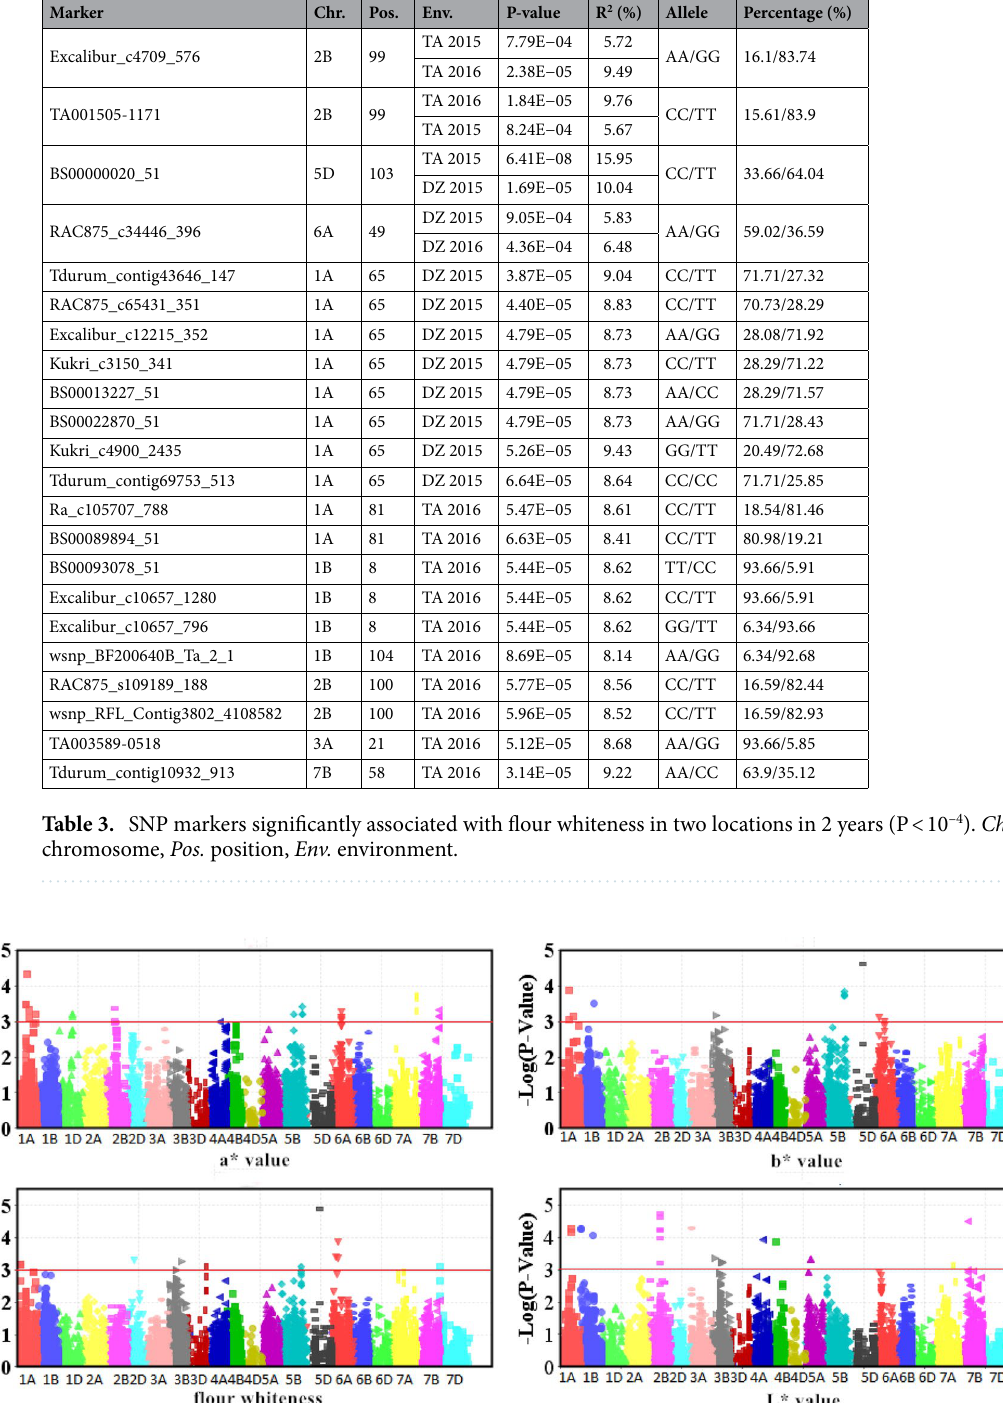
Prediction of candidate genes for dough sheet colour.